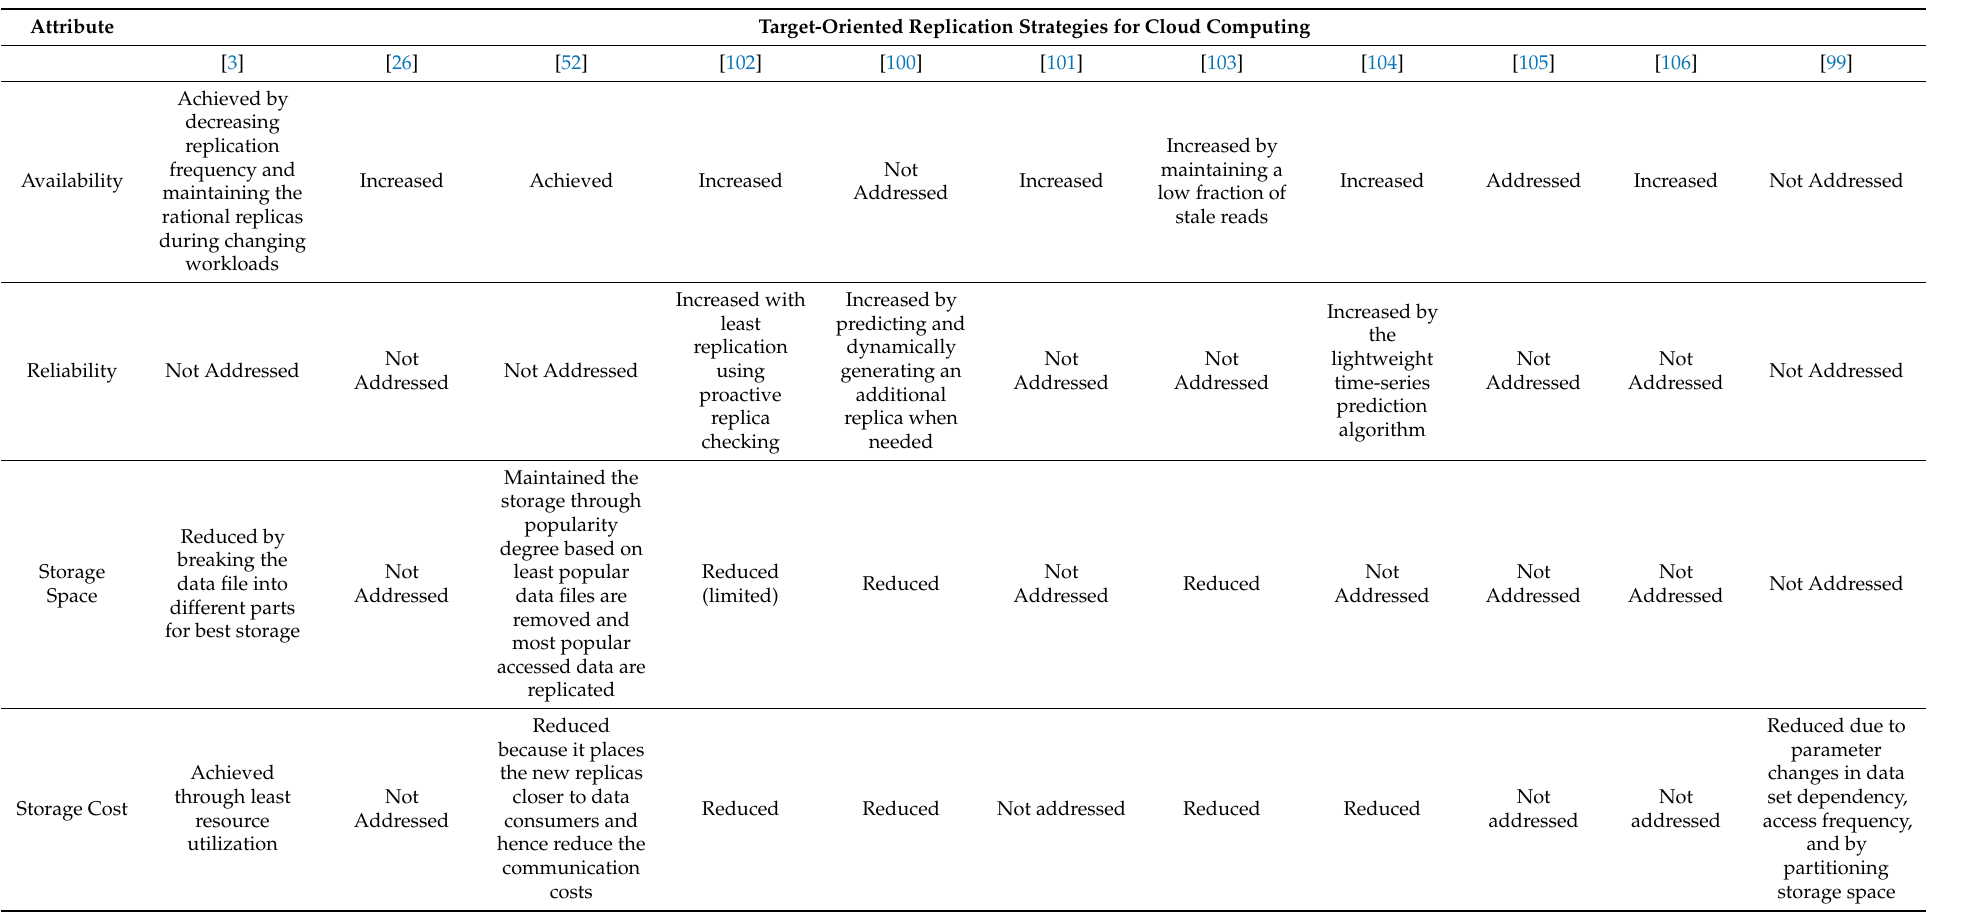
Table 6. Comparison evaluation of different target-oriented replication strategies in